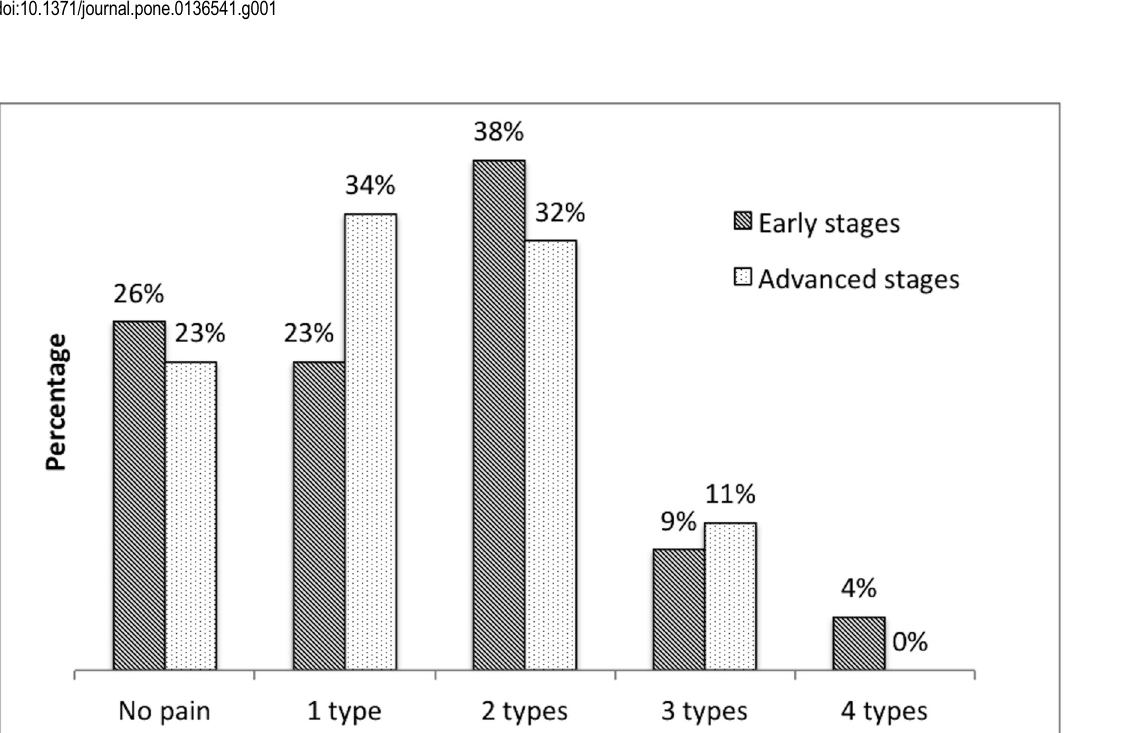
Fig 2. Types of pain in PD patients.